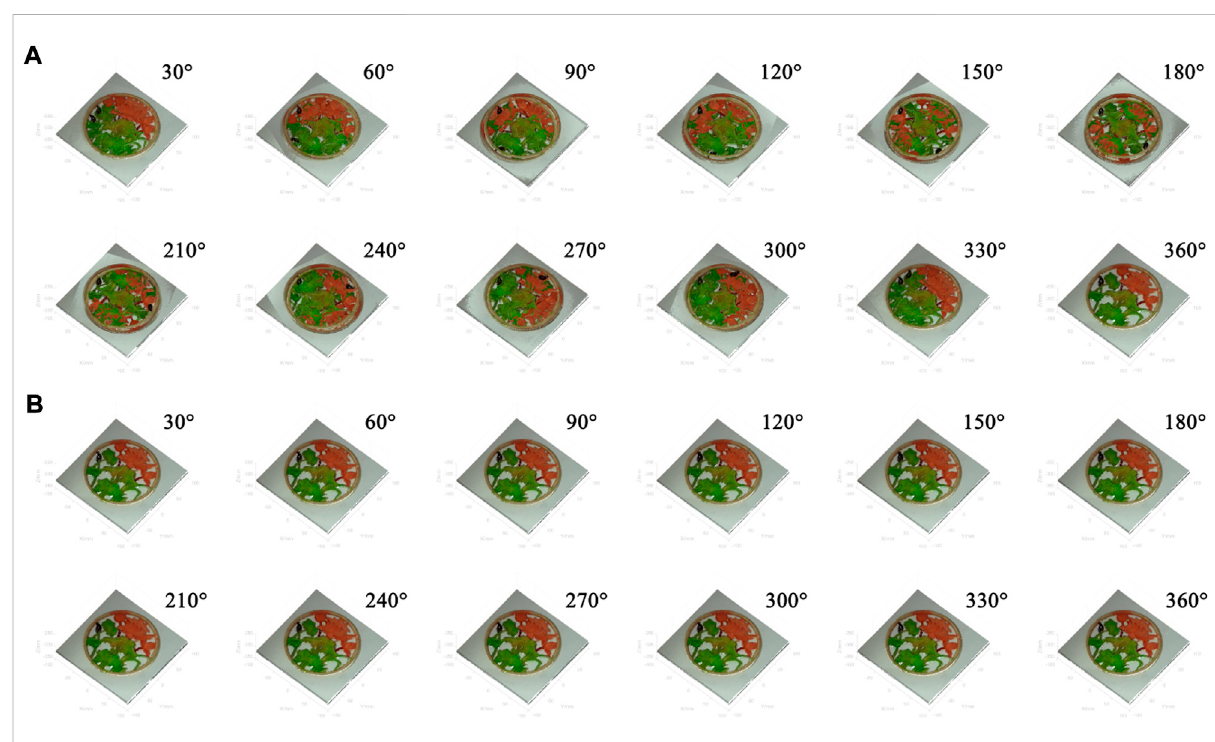
FIGURE 5 Registration results of two cluster point clouds, (A) ICP (B) Our method.